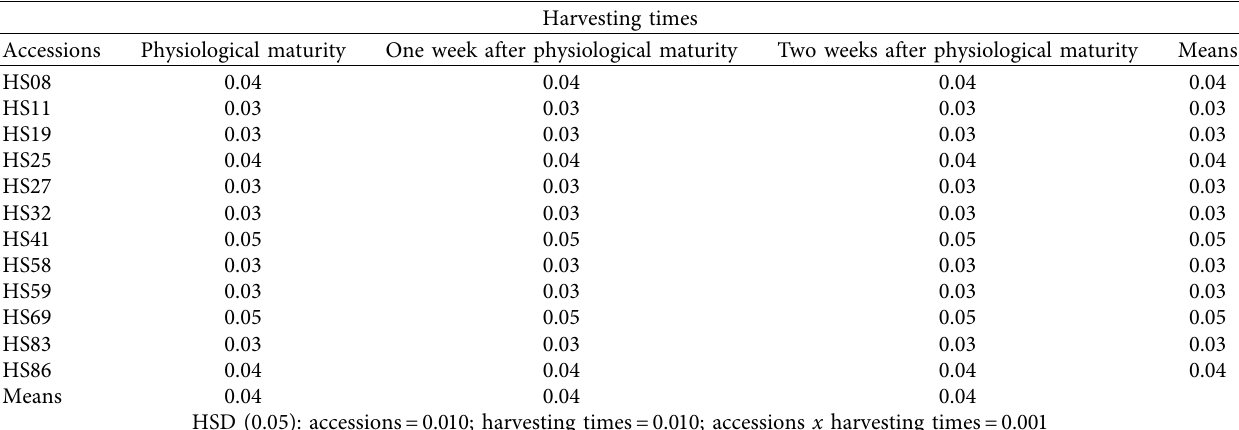
Table 7: Interactive effects of harvesting times x accessions on the 1000 seed mass (g) of